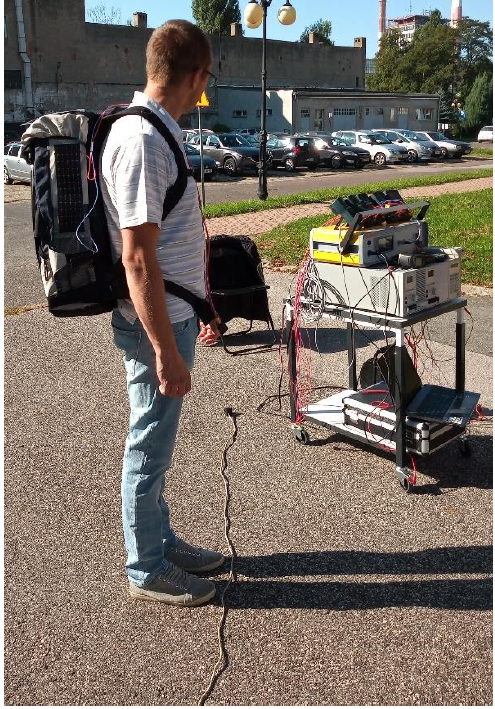
Figure 9. Measurement setup for static tests of PV module sets.